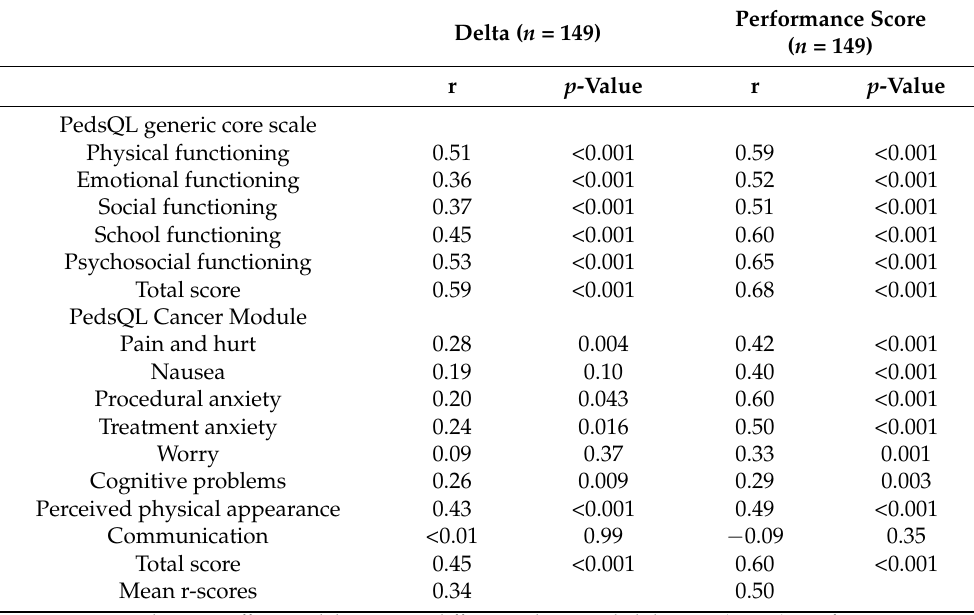
Table 7. Comparison of agreement in mean improvement during therapy between children and parents using the delta and the performance